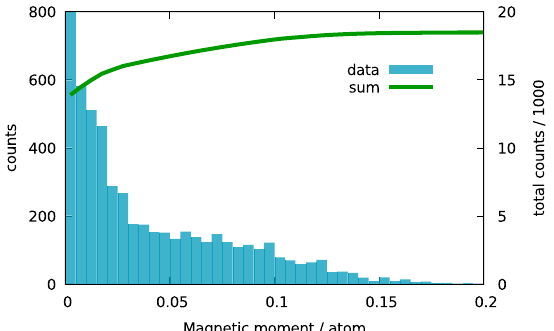
Fig. 5 Total magnetization. Histogram of the total magnetization per unit volume (in μ B ⋅ Å − 3 ) for all new stable